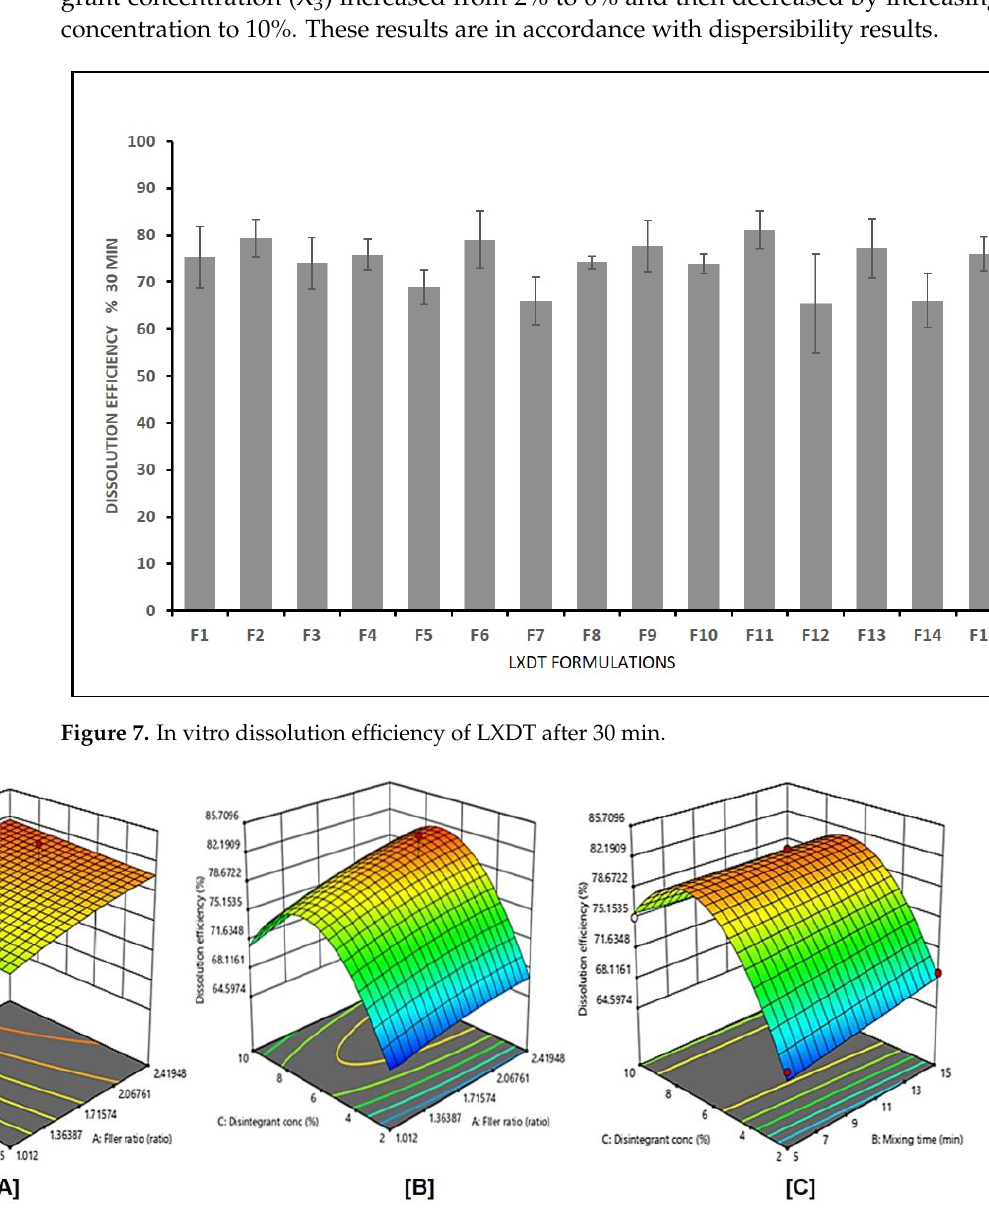
Figure 8 . Influence of independent variables on the Dissolution efficiency (Y3) with significance ( A ) p value = 0.1397, ( B ) p value = 0.0018, and ( C ) p value < 0.9079 . ( A ) p value = 0.1397, ( B ) p value = 0.0018, and ( C ) p value <